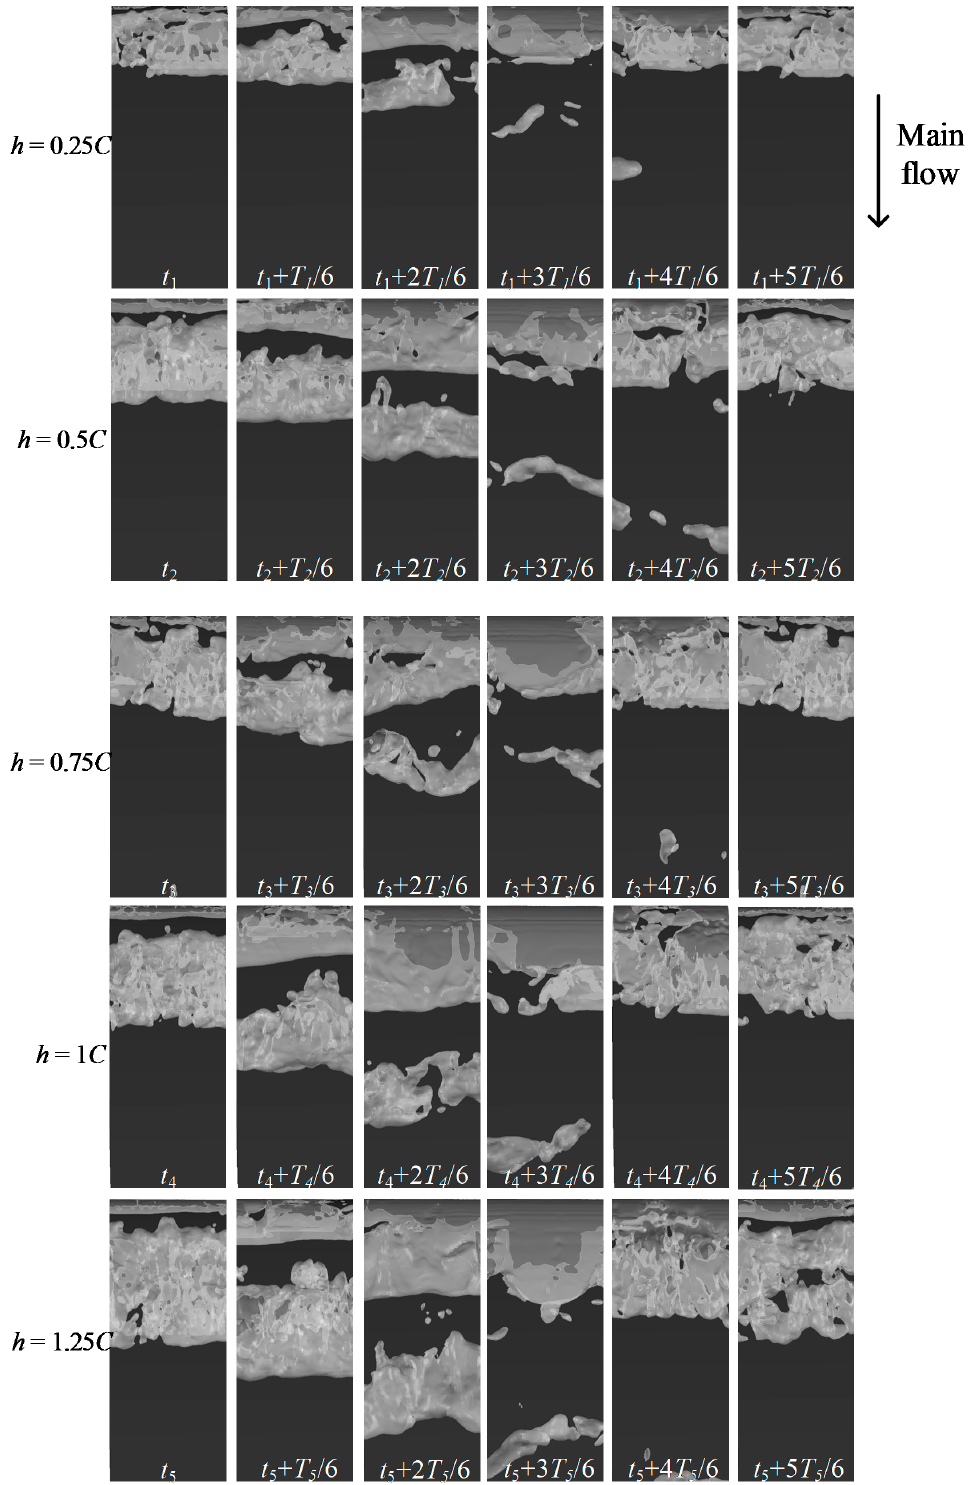
Figure 14. Comparison of cavity evolution in one typical cycle compared at five different water depths.